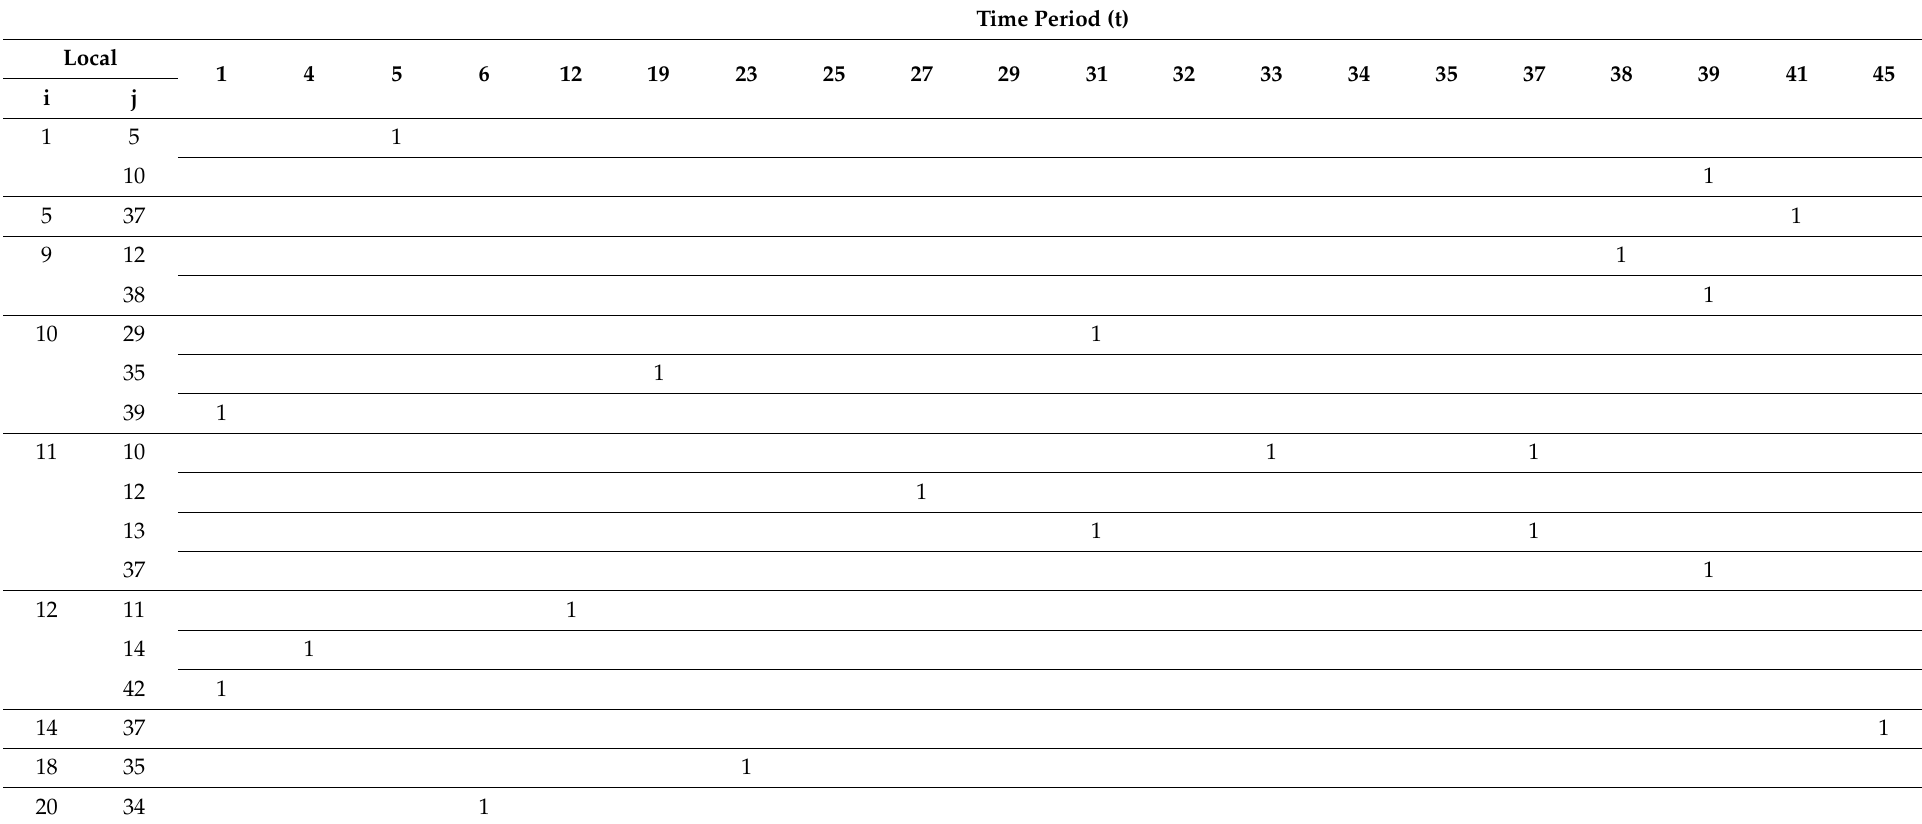
Table 13. Reallocation of batteries between local “i” and “j” over time with batteries in Group 1 and demand scenario 1. Time Period